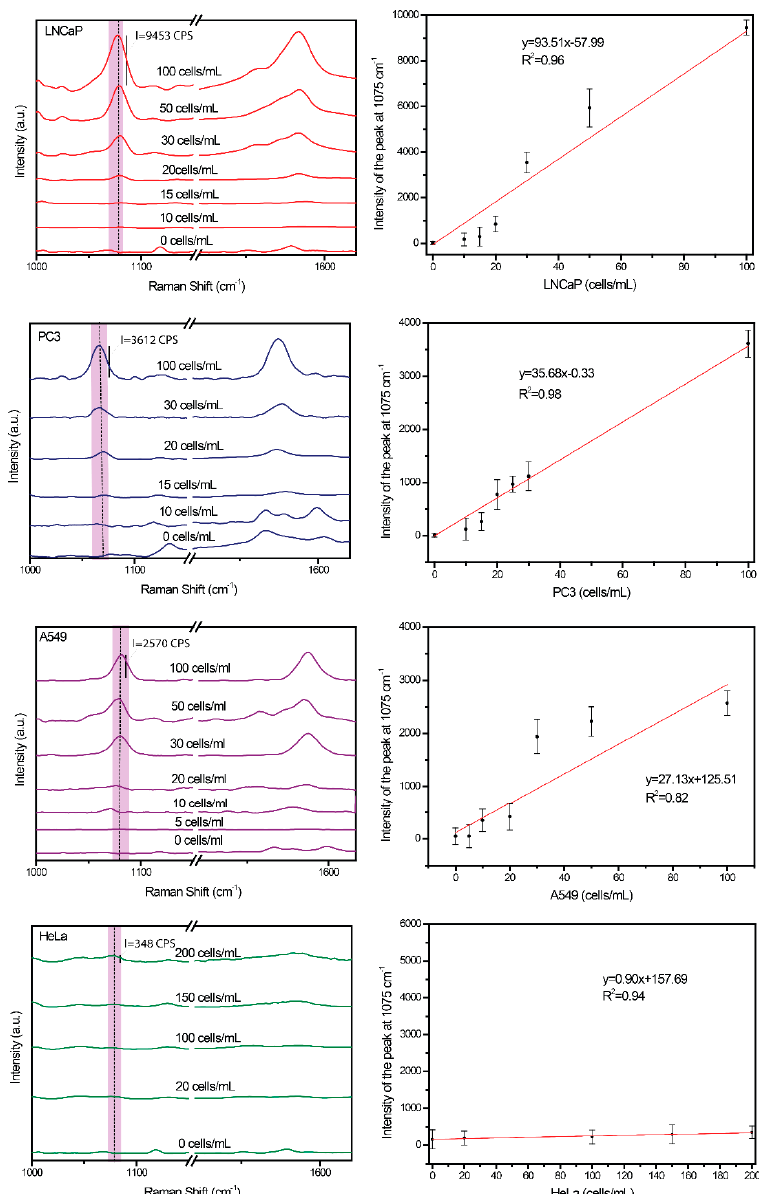
Figure 5. Averaged SERS spectra for LNCaP, PC3, A549, and HeLa in the range from 0 to 100 cells/mL in the peripheral blood, and the corresponding calibration curves.